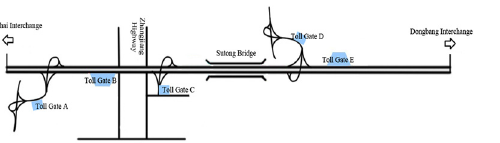
Fig 1. A general view of the segment of National Freeway G15 (Kilometer post: k1184+275~k1215